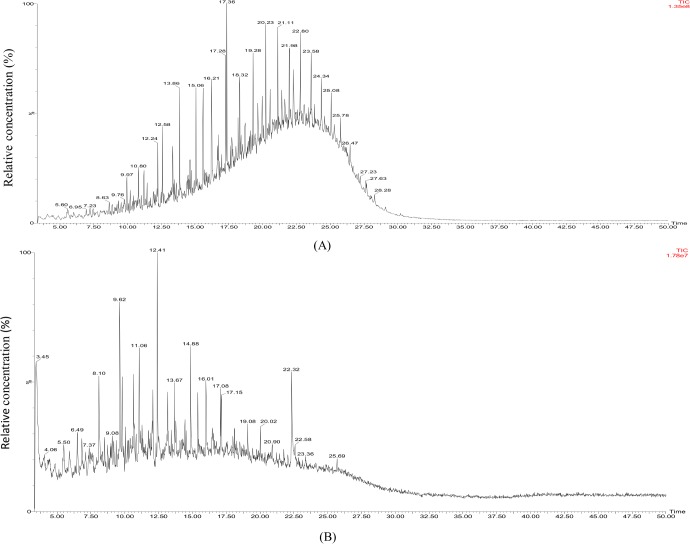
GC-MS analysis of (A) Control heavy crude oil, (B) Extra recovered oil by the action of P. ehimensis strain BS1. The relative concentration of the lighter hydrocarbons is greater in extra recovered oil compared to the control, crude heavy oil.